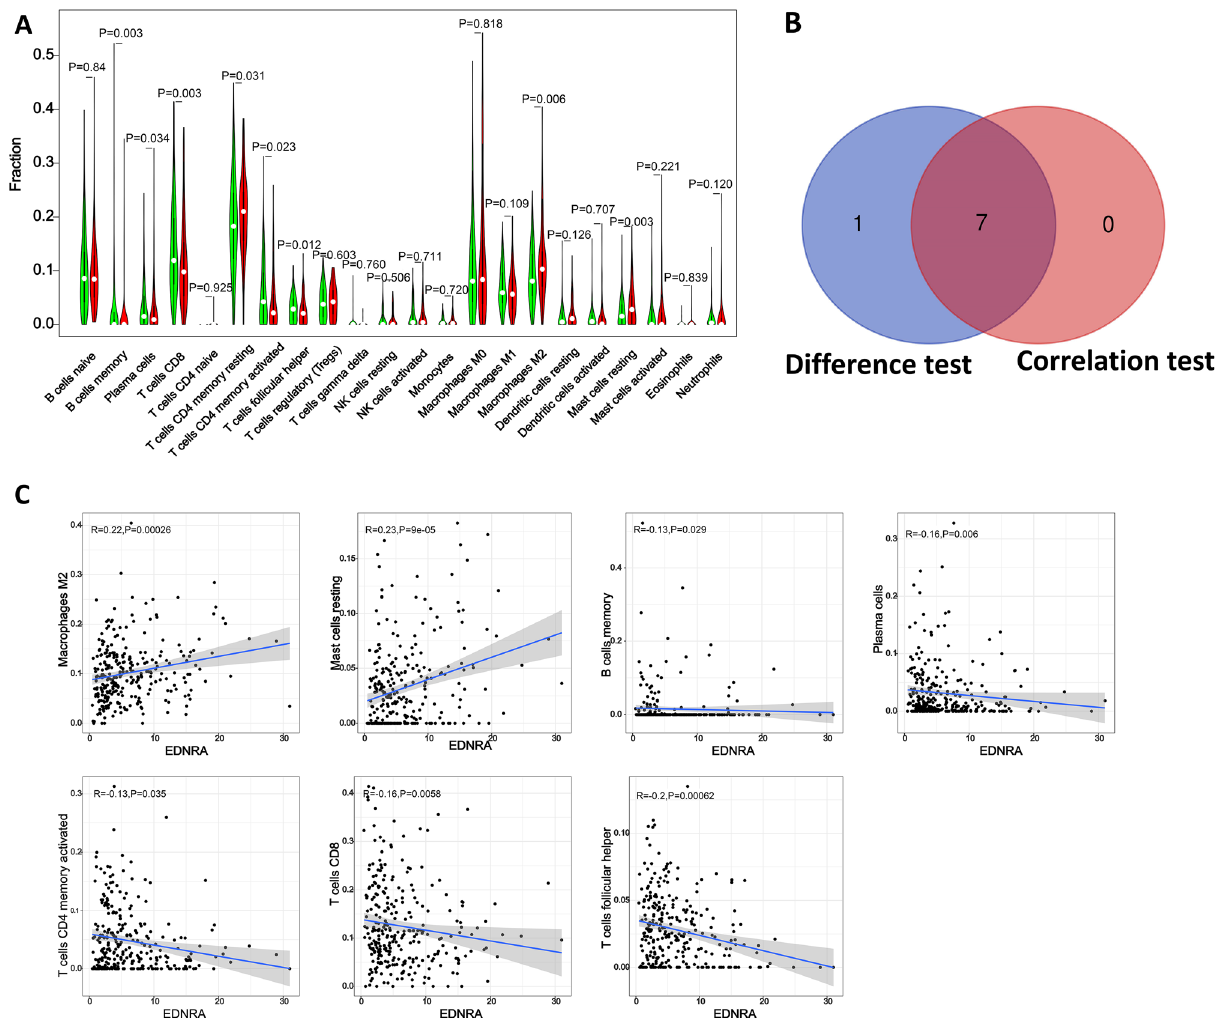
Figure 5. The association between the proportion of tumor immune cells and EDNRA expression. ( A ) Violin plots present the ratio differentiation of 22 immune cells between gastric cancer tumor samples with EDNRA expression. ( B ) Venn diagram showing immune cells with significant differences and correlations with EDNRA expression. ( C ) Scatter plots show that the proportion of immune cells was correlated with EDNRA expression (P <